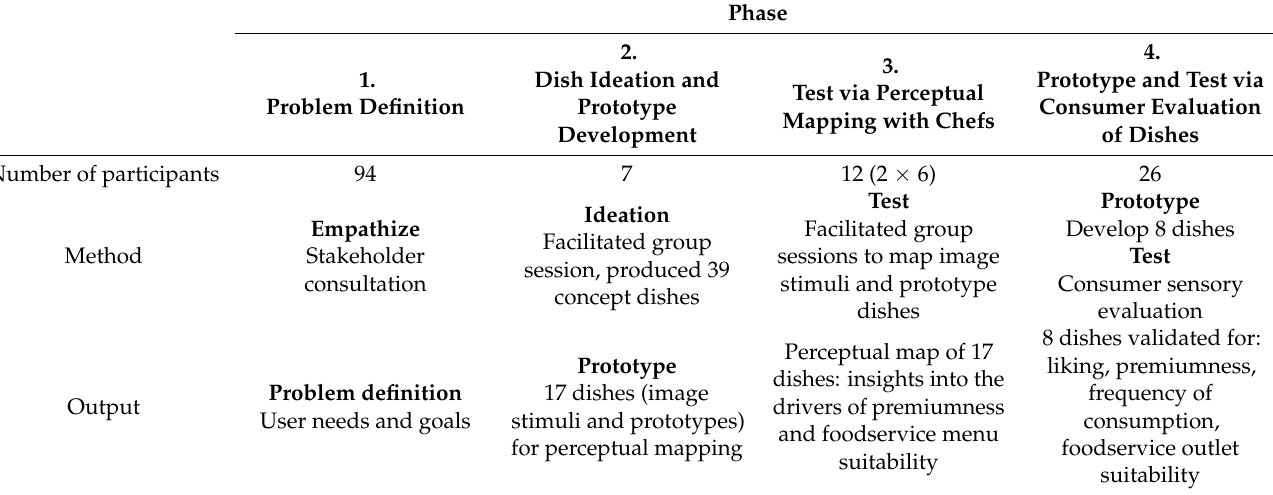
Table 1. Overview of this study’s structure aligned with design thinking